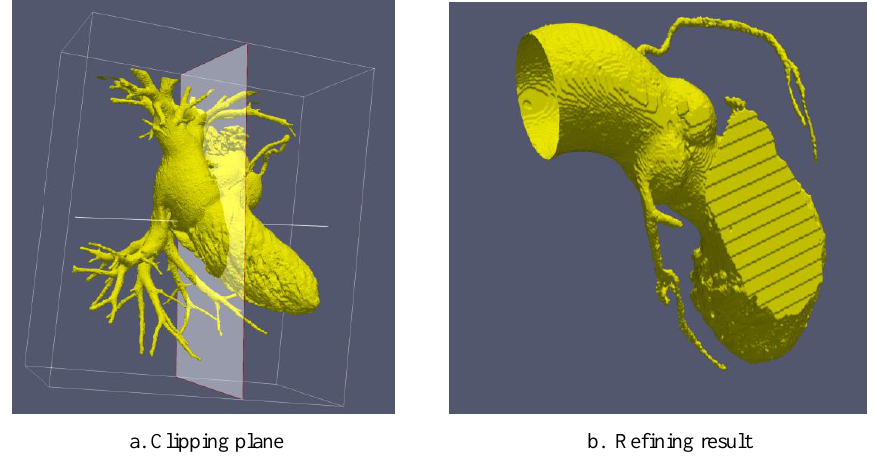
Fig. 9. The first refining. a) The plane used to clip the segmentation; b) the processing result after clipping and